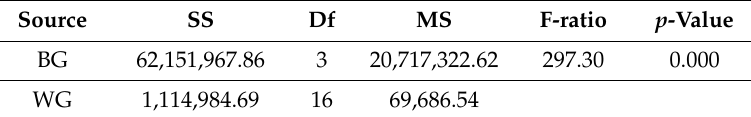
Table 5. ANOVA test for flexural modulus of five samples.